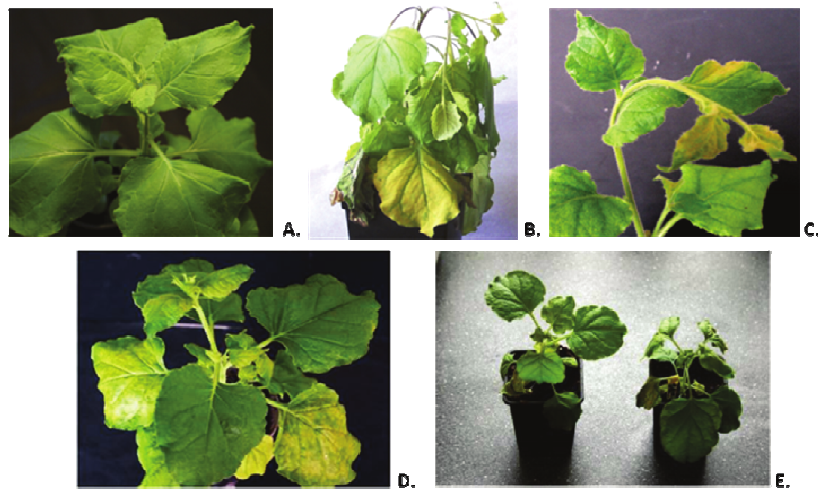
Figure 1. ( A ) Mock-inoculated plant (14 days post inoculation (d.p.i.)). ( B )